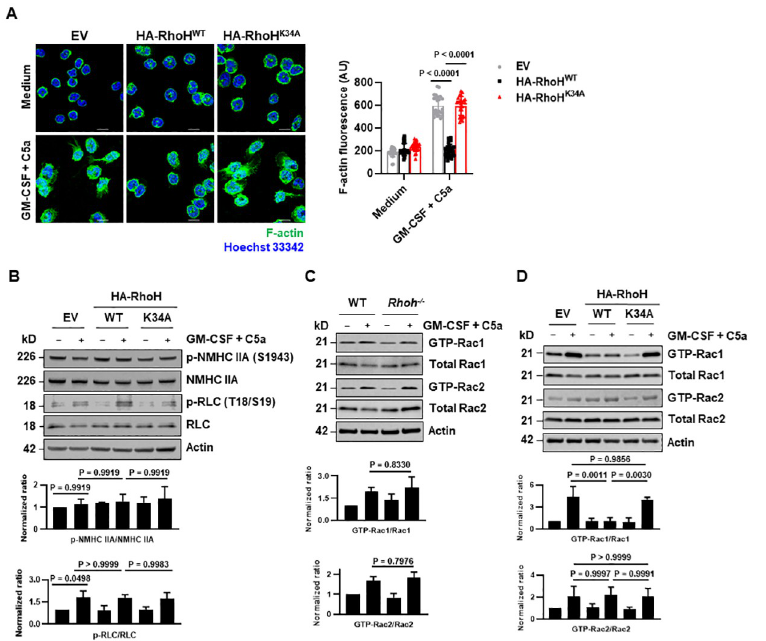
Fig 6. RhoH impairs actin rearrangement presumably by modulating Rac1 activity. ( A, B ) Mature HoxB8 neutrophils expressing WT or mutated HA-RhoH or EV were treated as indicated. ( A ) F-actin distribution was analyzed by confocal microscopy (left). Scale bars, 10 μ m. Quantification of F-actin fluorescence intensity was performed by automated analysis of microscopic images using Imaris software. The 25 images (each containing 8–12 cells) from 3 independent experiments were included for each condition (right). ( B ) Phosphorylation of myosin IIA was analyzed by immunoblotting. ( C, D ) The levels of GTP-bound and total Rac1 and Rac2 proteins in the indicated mouse bone marrow (BM) neutrophils (C) and HoxB8 neutrophils (D) were examined by immunoblotting following pulldown assay. All data are representative of 3 independent experiments. Values are means ± SD. One-way ANOVA with Tukey’s multiple comparisons test was applied. The underlying numerical data for Fig 6A–D can be found in S1 Data. The uncropped immunoblots for Fig 6B–D can be found in S1 Raw images. EV, empty vector; WT, wild-type.